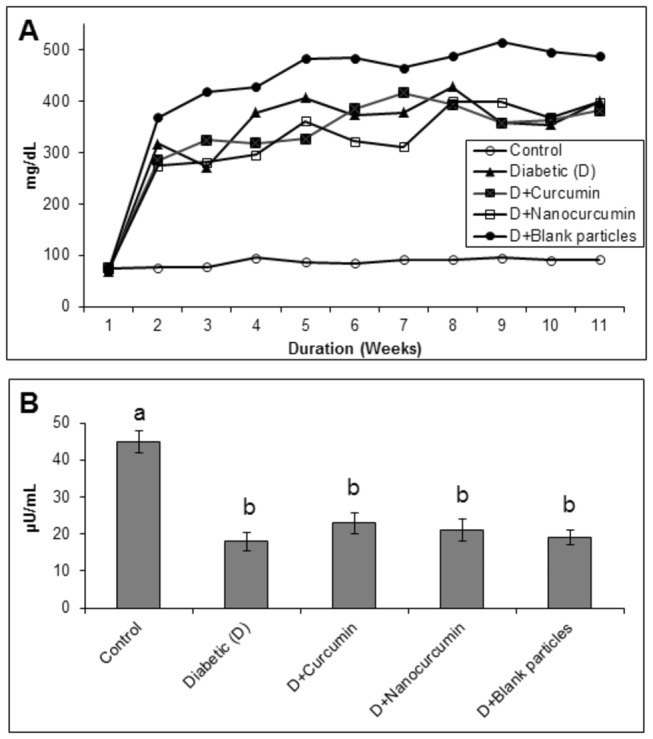
The effect of curcumin and nanocurcumin on blood glucose (Panel A) and insulin levels (Panel B) in STZ-treated rats.Data are average of all the animals in a given group. Different superscripts in Panel B indicate data are significantly different from other groups.